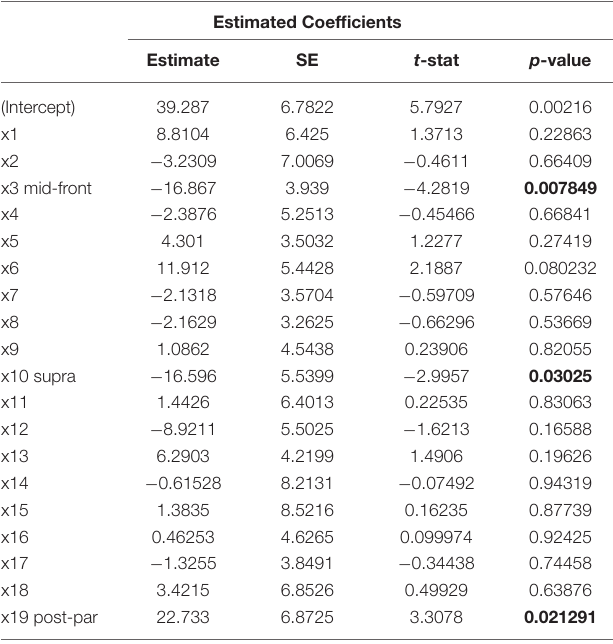
TABLE 3 | Estimated coefficients in a linear regression model with IC pairs and SDMT